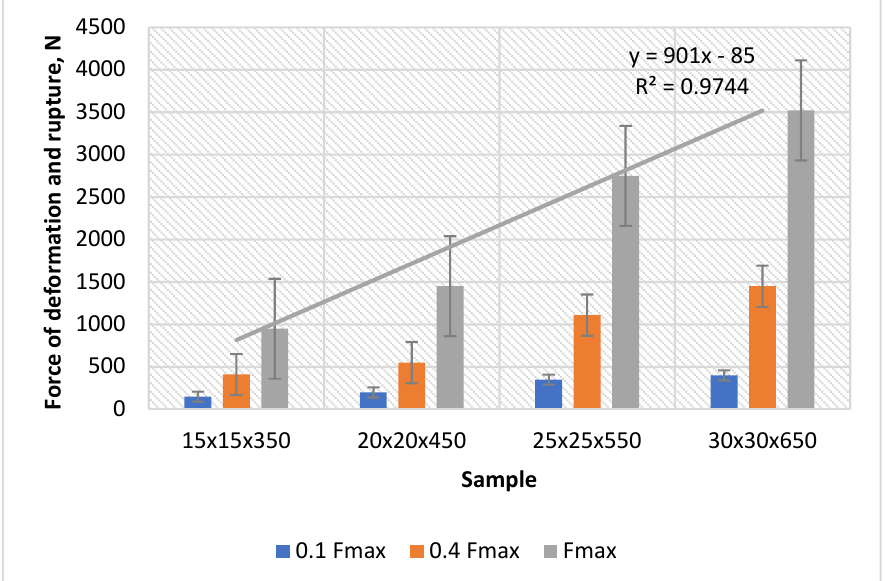
Figure 6. The evolution of the deformation forces until the breaking of the specimen.